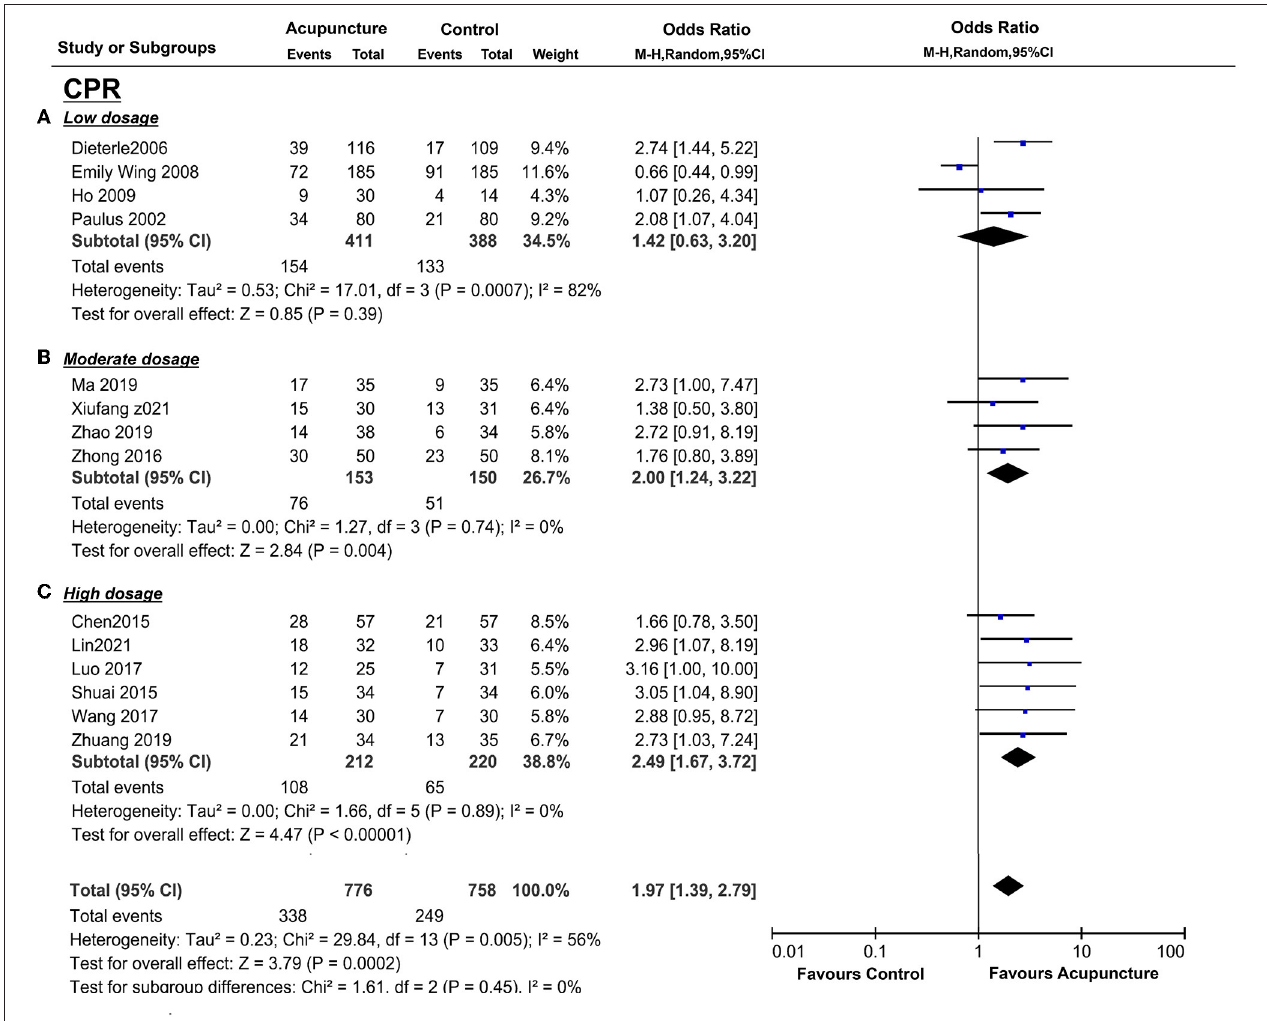
FIGURE 4 | Effects of acupuncture on CPR based on intervention of low dosage (A) , moderate dosage (B) , and high dosage (C) .